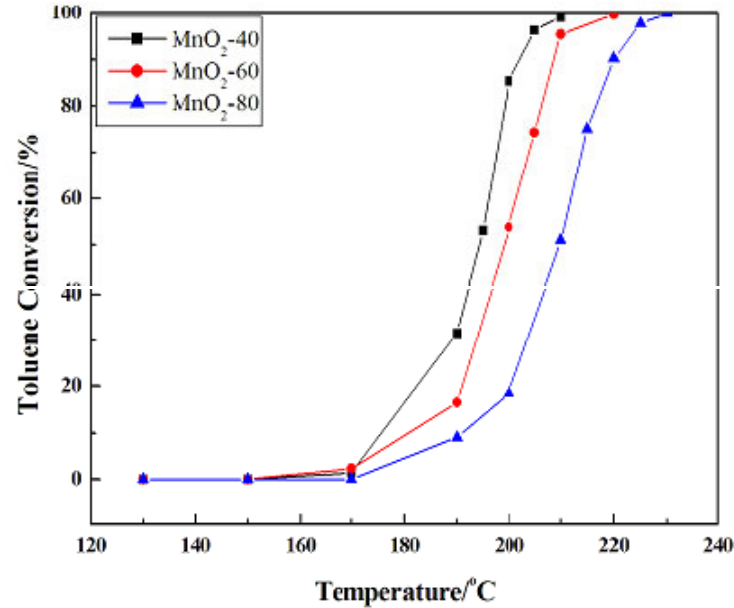
Figure 19. Catalytic combustion of toluene activity over α -MnO 2 obtained at different temperatures. Reprinted with permission from Ref. [40]. Copyright 2016 Elsevier.